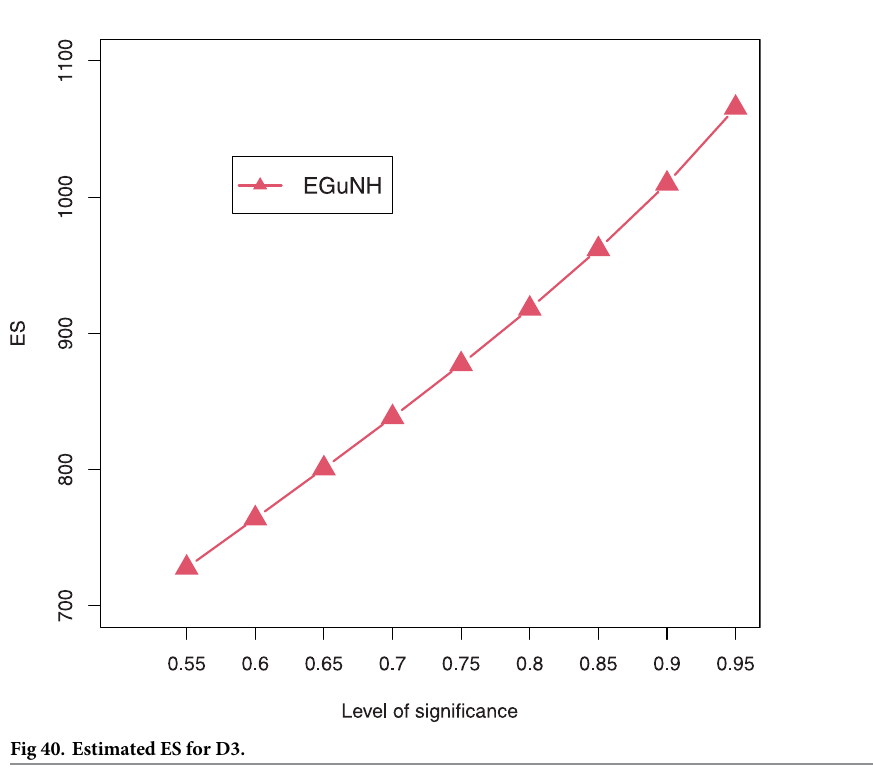
Fig 40. Estimated ES for